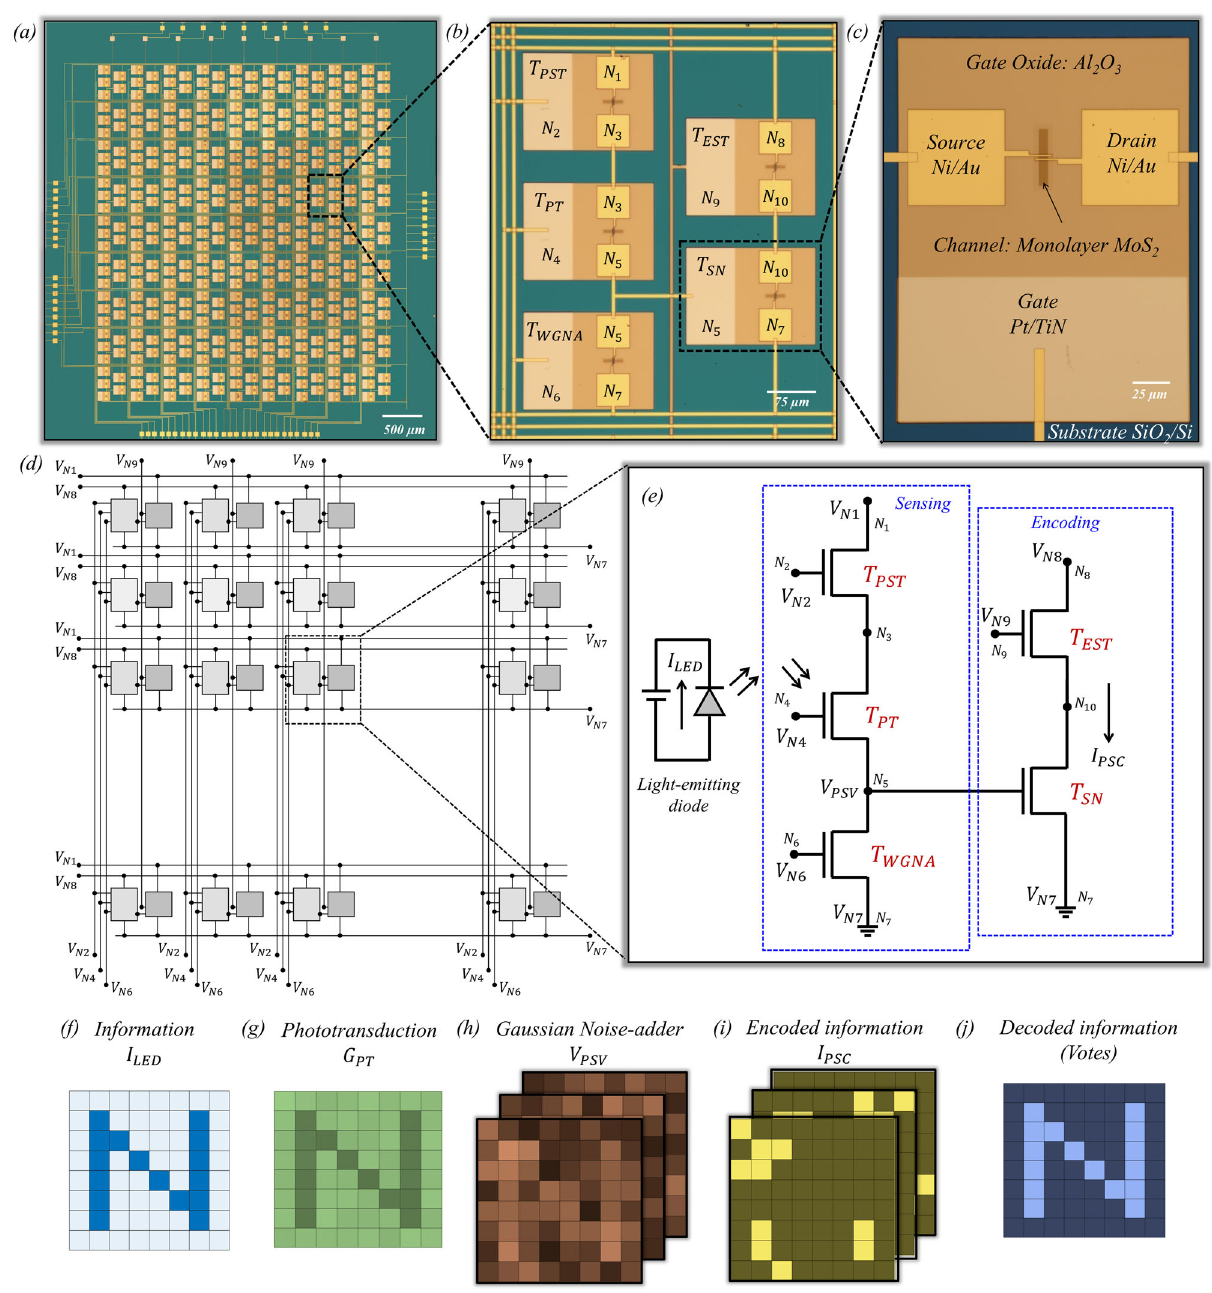
Fig. 1 All-in-one hardware fabric for near sensor security based on multifunctional MoS 2 memtransistors. Optical images of ( a ) the fully integrated 8 × 8 crossbar array of crypto engines, ( b ) a representative crypto engine with fi ve MoS 2 memtransistors (5T cell) that integrate sensing, storage, and encoding functionalities, and ( c ) an individual MoS 2 memtransistor, which is locally back-gated using a stack comprising 50 nm Al 2 O 3 on 40/30 nm Pt/TiN. All back-gate islands were placed on an SiO 2 /p ++ -Si substrate. Equivalent circuit diagrams for ( d ) the 8 × 8 crossbar array with column and row select lines and ( e ) each crypto engine. Herein, the MoS 2 memtransistor used as T PT mimics sensory neurons and transduces optical information into persistent photoconductance (G ), the MoS 2 memtransistor used as T emulates noisy synapses, the MoS 2 memtransistor used as T imitates spiking neurons PT WGNA SN converting noisy presynaptic information, i.e., V PSV , into post-synaptic current spikes (I PSC ), and the remianing 2 MoS 2 memtransistors, T PST and T EST , operate as the individual selector switches for the photosensing and the encoding operations, respectively. An example experimental demonstration of sensing and ciphering, where ( f ) the information, for example, an 8 × 8 pixelated image of the letter ‘ N ’ obtained by illuminating a blue light emitting diode (I ) is presented to the corresponding 8 × 8 array of the crypto engines. Colormap of ( g ) post-illumination G , ( h ) noisy V , and ( i ) encrypted I . LED PT PSV PSC j The information is revealed by a decoder through a voting